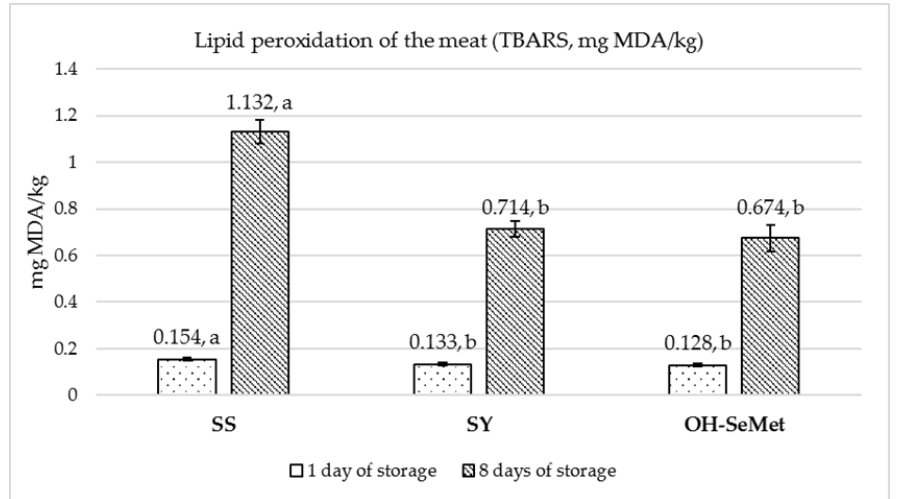
Figure 1. Effect of the selenium sources on the level of thiobarbituric acid reactive substances (TBARS, mg/kg of malondialdehyde - MDA) in the meat during 1 and 8 days of storage. SS—so-